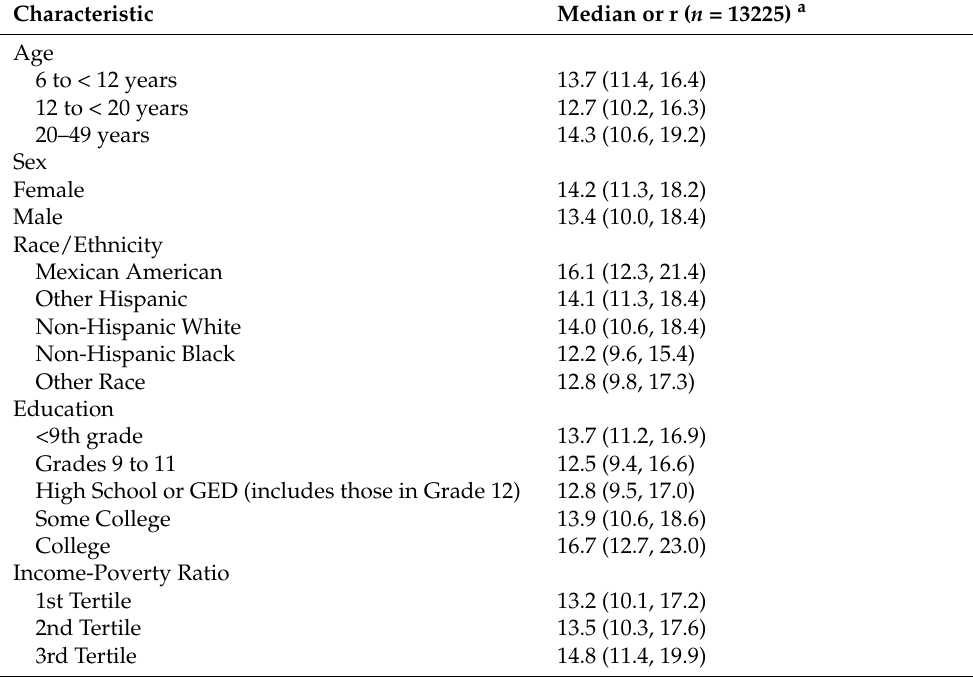
Table 2. Age-adjusted median amount of energy-adjusted dietary fiber (g/day) according to category of subject characteristic (and quartiles) or Pearson correlation coefficient of energy-adjusted